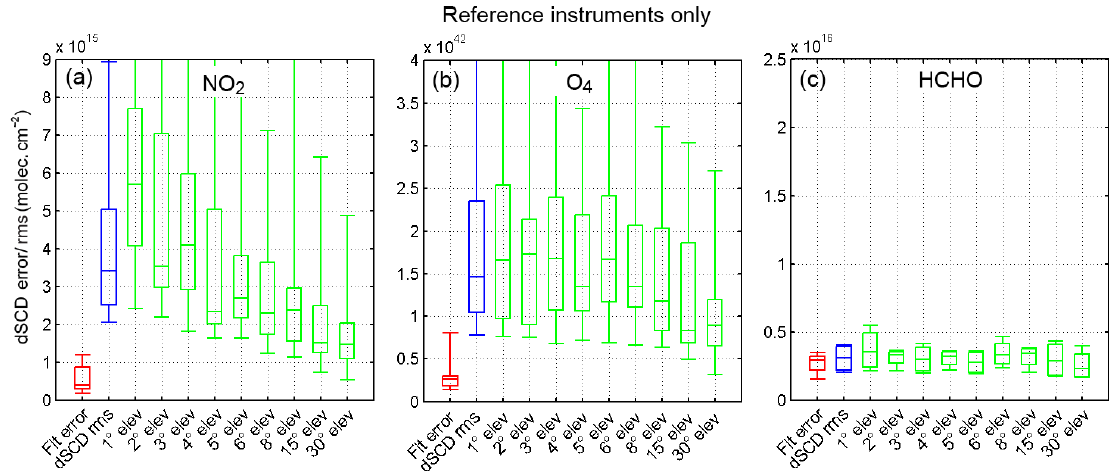
Figure 15. Same as Fig. 14, but for reference instruments only.